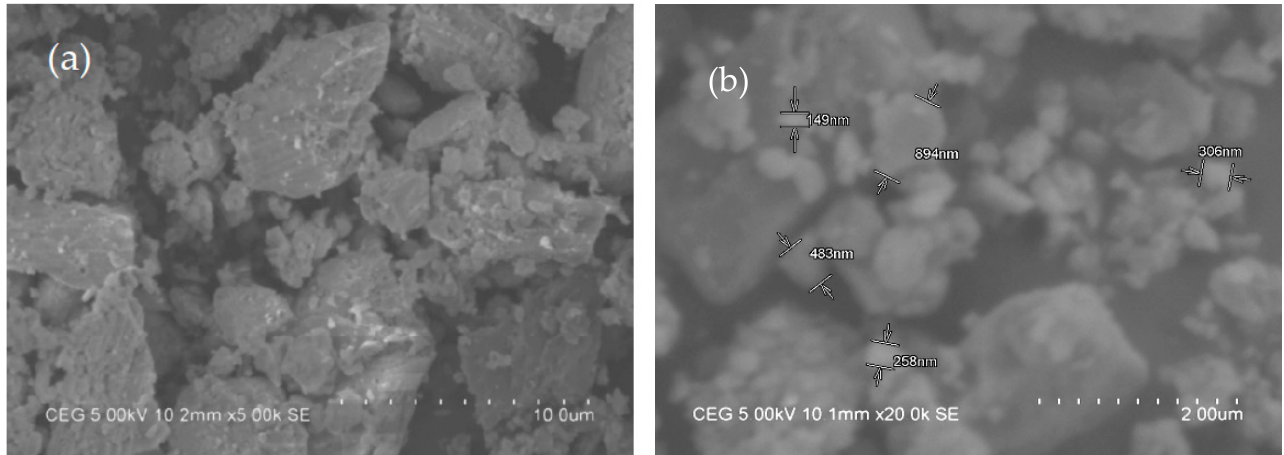
Figure 5. Five-liter capacity biodiesel production plant.